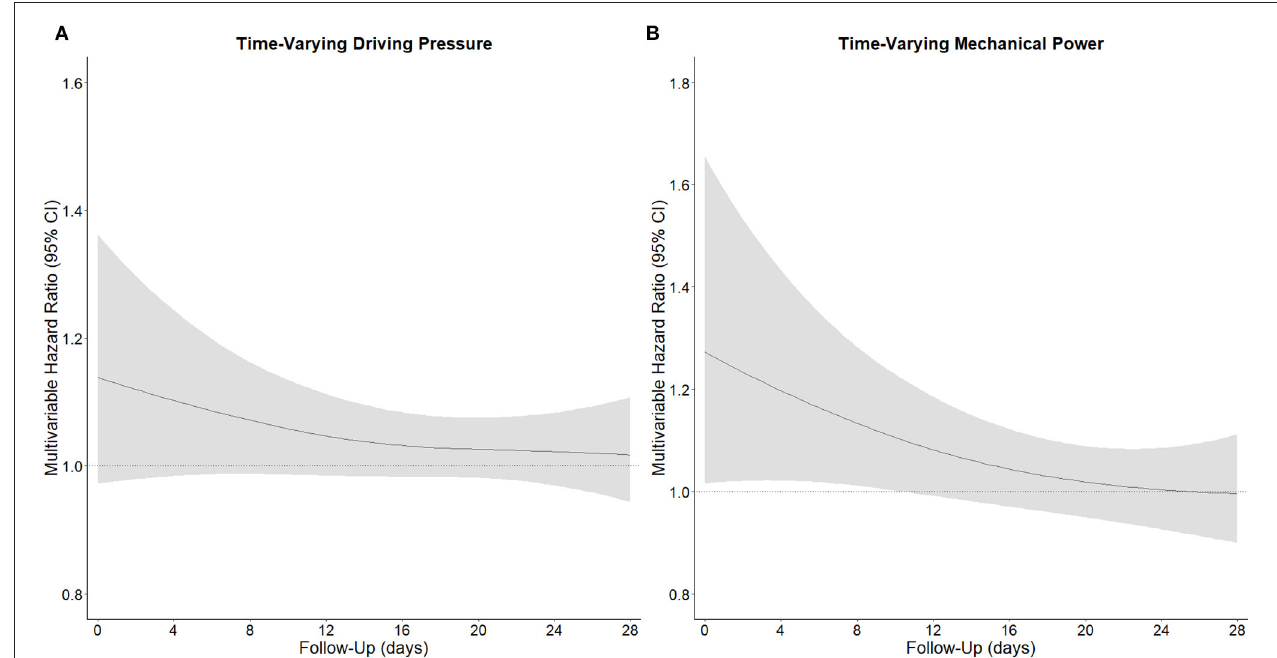
FIGURE 2 | Time-varying hazard ratio of driving pressure and mechanical power for 28-day mortality. (A) , Time-varying 1 P, and (B) time-varying MP. Time-varying hazard ratio obtained from a Bayesian joint model estimating the association between 1 P and MP and 28-day mortality, including p-splines in an interaction term. The strength of the association decreased over time. All models were adjusted for age, gender, body mass index, PaO 2 to FiO 2 ratio, plasma creatinine, medical history of hypertension, heart failure, diabetes, chronic kidney disease, chronic obstructive pulmonary disease, active hematological neoplasia and/or active solid tumor, use of angiotensin converting enzyme inhibitors, use of angiotensin II receptor blockers, use of a vasopressor or inotropes, fluid balance, arterial pH, mean arterial pressure, and heart rate. Natural cubic splines were used in both the fixed-effects and random-effects models to account for the nonlinearity of the longitudinal exposure